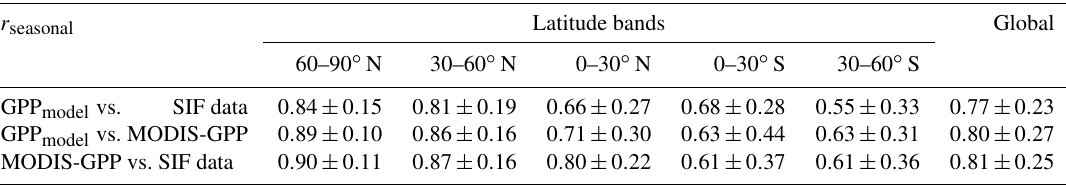
Table 4. Mean ± standard deviation of r seasonal comparing the seasonal cycle of modelled GPP (GPP model ) , MODIS-GPP, and SIF data for the five latitude bands and global scale. r seasonal is expressed as mean ± standard deviation of grid level correlation coefficient within each latitude band and global. To avoid the strong impact of other land-cover types (e.g. crop and forest) to the seasonal cycle, we only consider r seasonal for grid cells with grassland covering more than 50% of total land in the MOD12Q1 dataset.